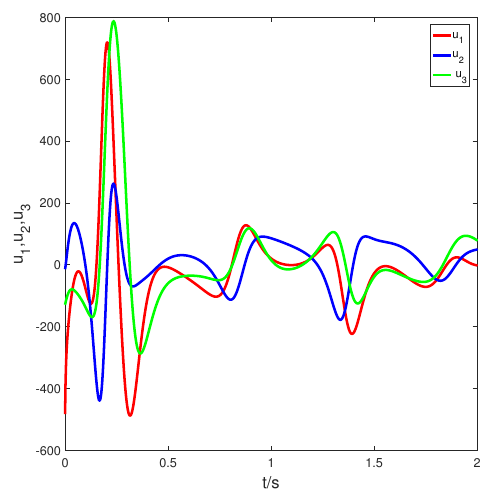
Figure 4. Switch 2 control input of error